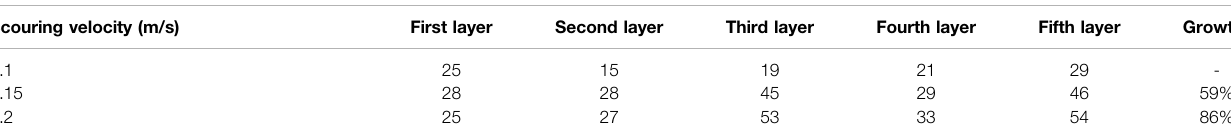
TABLE 3 | Denudation amount of the 60 ° slope under the FT